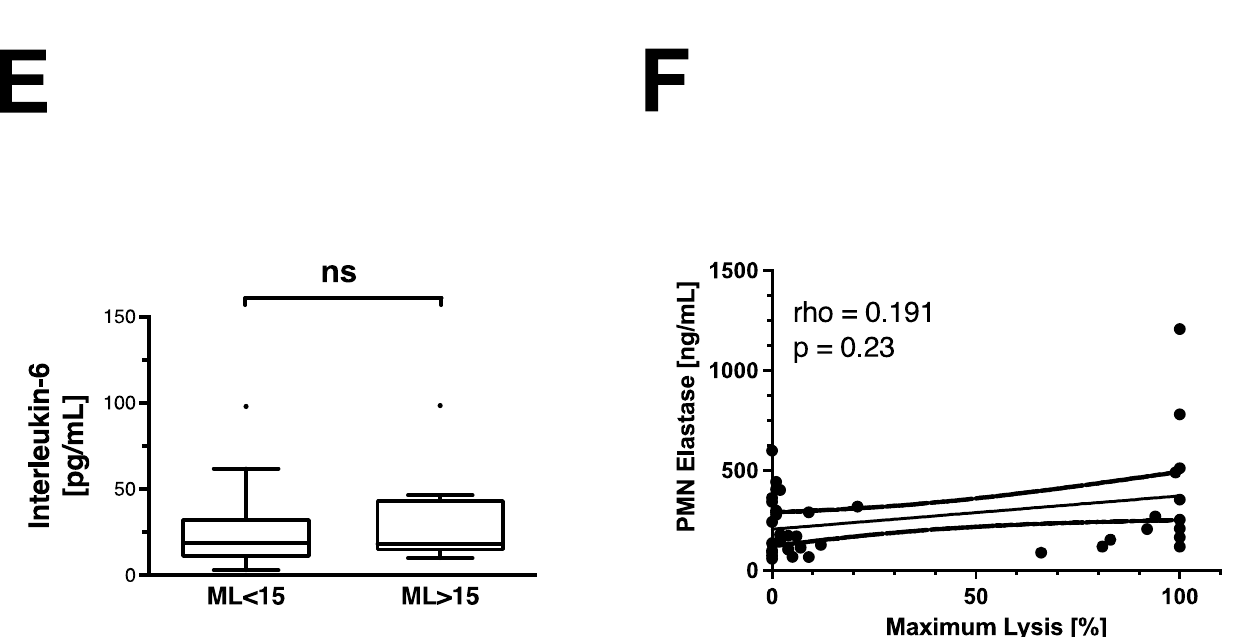
Figure 3. Inflammatory markers and features of neutrophil extracellular trap release in OHCA pa- tients. Differences in ( A ) neutrophil elastase, ( C ) histonylated DNA fragments, and ( E ) interleukin-6 levels in OHCA patients with and without hyperfibrinolysis. Data are shown as box and whiskers blots with Tukey-style depiction of outliers. OHCA patients were stratified by ROTEM maximum lysis (ML). Hyperfibrinolysis was defined as a ML > 15%. Parameters in patients with and without hyperfibrinolysis were compared with a Student’s t -test or Mann–Whitney test, where applicable. Spearman correlation of ( B ) histonylated DNA fragments and neutrophil Elastase; ( D ) activated protein C–protein C inhibitor (APC/PCI) complex and neutrophil elastase; and ( F ) neutrophil elas- tase and ROTEM maximum lysis in all OHCA patients. PMN = polymorphonuclear neutrophil; OD = optical density; ns =